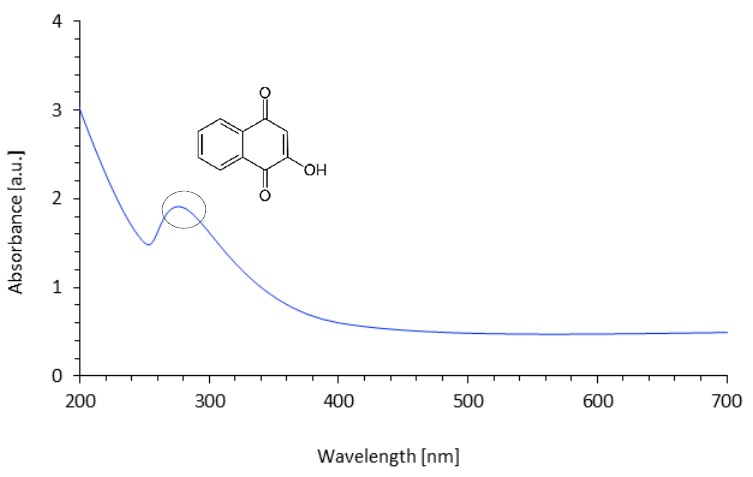
Figure 4. UV–VIS spectrum of coir-fiber filler treated with henna.